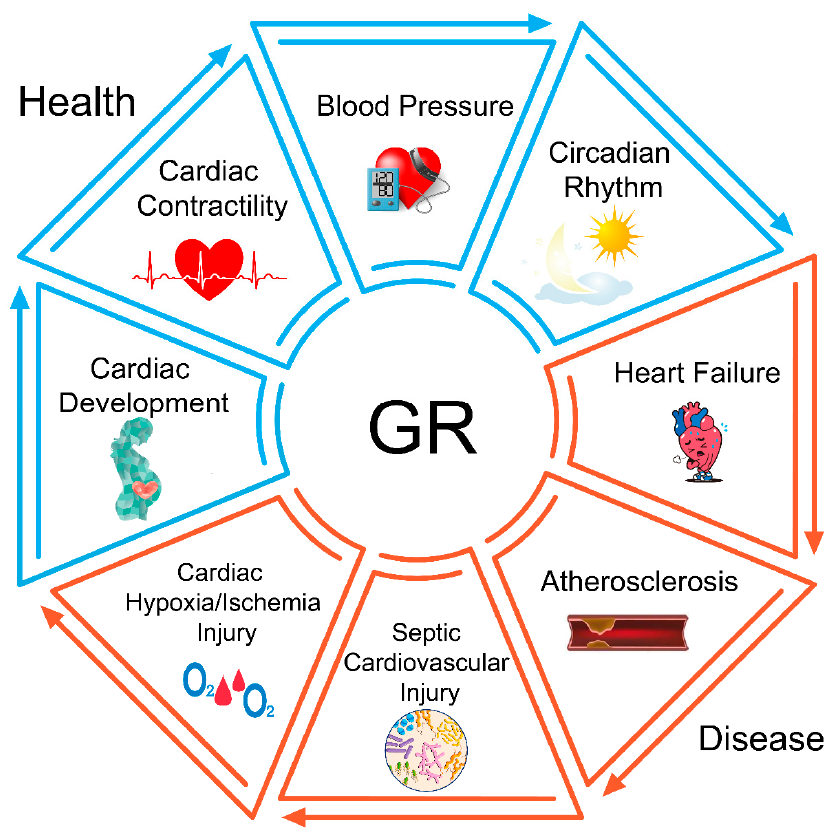
Figure 4. GR influences a variety of physiological processes in states of health and disease.